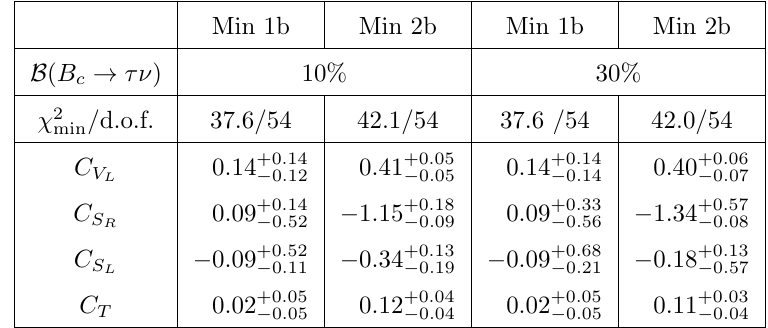
Table 3 . NP parameters for the minima obtained from the χ 2 minimization including F D ∗ their 1 σ uncertainties. There are, in addition, the corresponding sign-flipped minima, as indicated in eq.